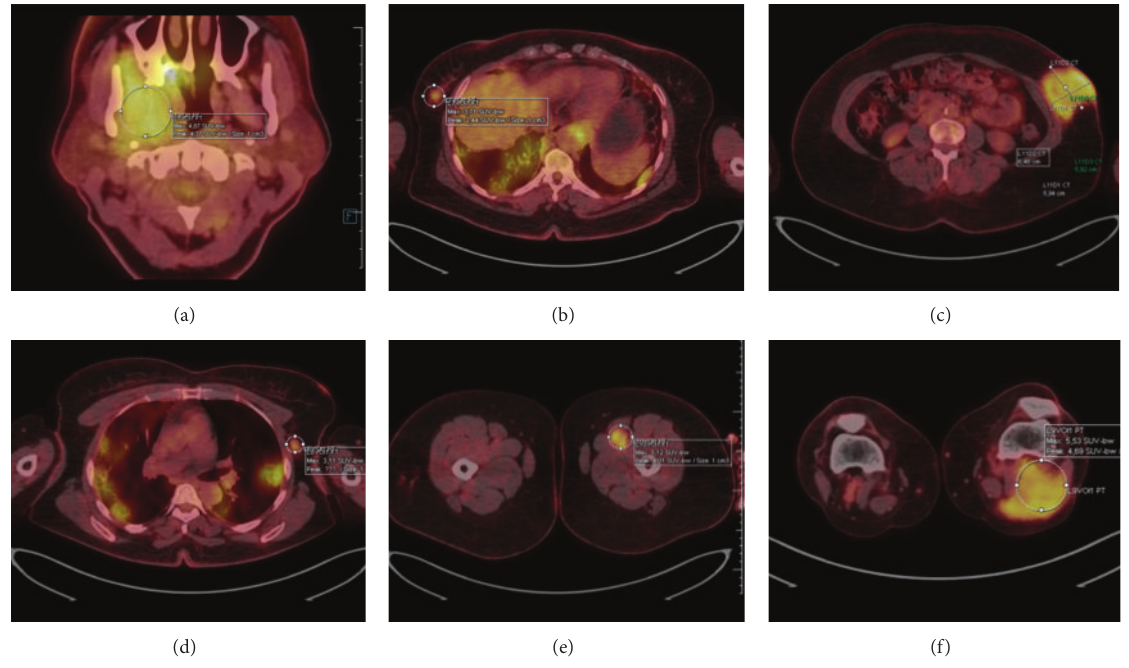
Figure 8: Positron emission tomography (PET-CT) : there were hypermetabolic lesions at previously known locations, such as the right masticator space (a), right breast (b), left abdominal wall (c), and left popliteal fossa (f), and also locations that were not previously diagnosed such as left axillary lymph node (d) and the left thigh muscle (e).